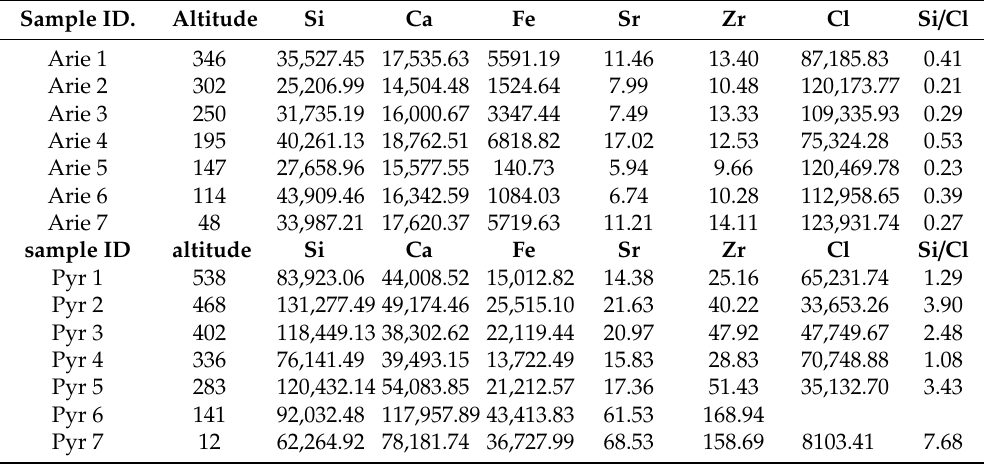
Table 3. Elemental composition of the sediment samples (in ppm) from Ariekammen and Pyramiden sampling sites; accompanied with Si / Cl ratio. Sample